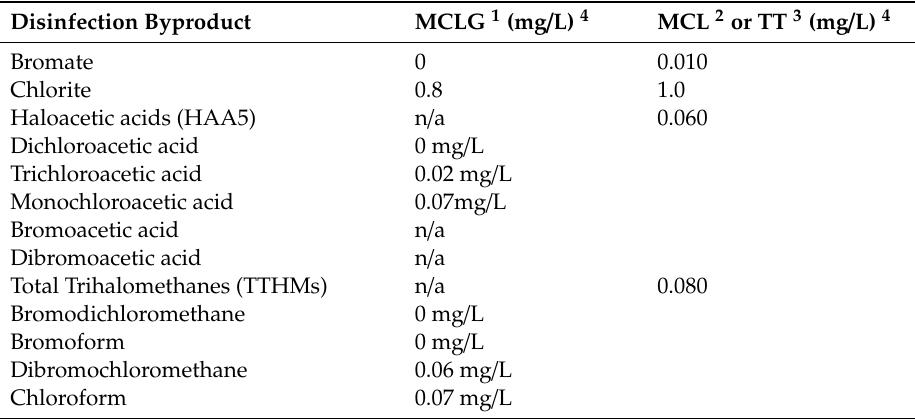
Table 1. USEPA Drinking Water Regulations for